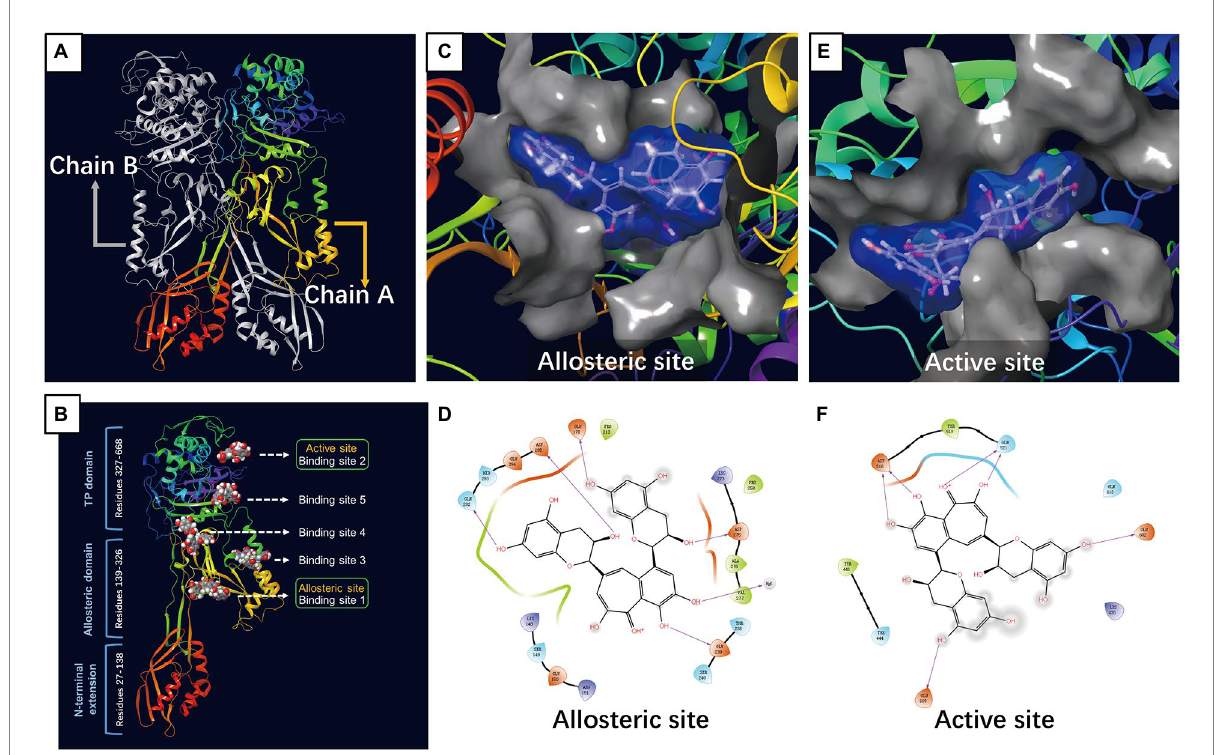
FIGURE 1 Molecular docking of TF to PBP2a of MRSA. (A) PBP2a protein structure (PDB: 6H5O). (B) The structure of PBP2a showing 5 binding sites bound to TF. (C) Surface representation of allosteric site bound to TF. (D) Amino acid residues and the nature of the interaction between TF and PBP2a at the allosteric site. (E) Surface representation of active site bound to TF. (F) Amino acid residues and the nature of the interaction between TF and PBP2a at the active site.